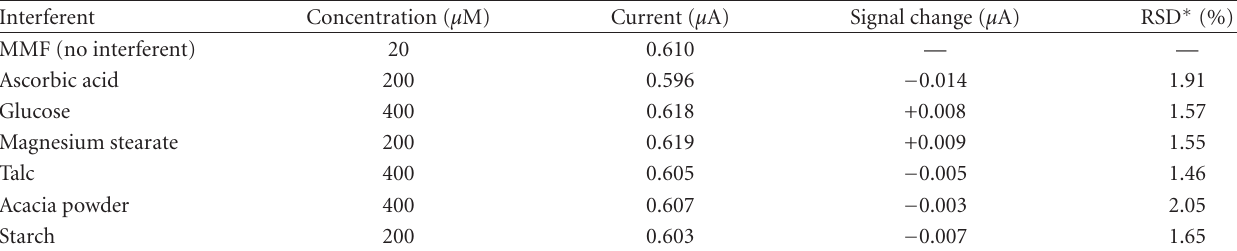
Table 2: E ff ects of interferents on di ff erential pulse voltammetric response of 20 μ M MMF at GCE.